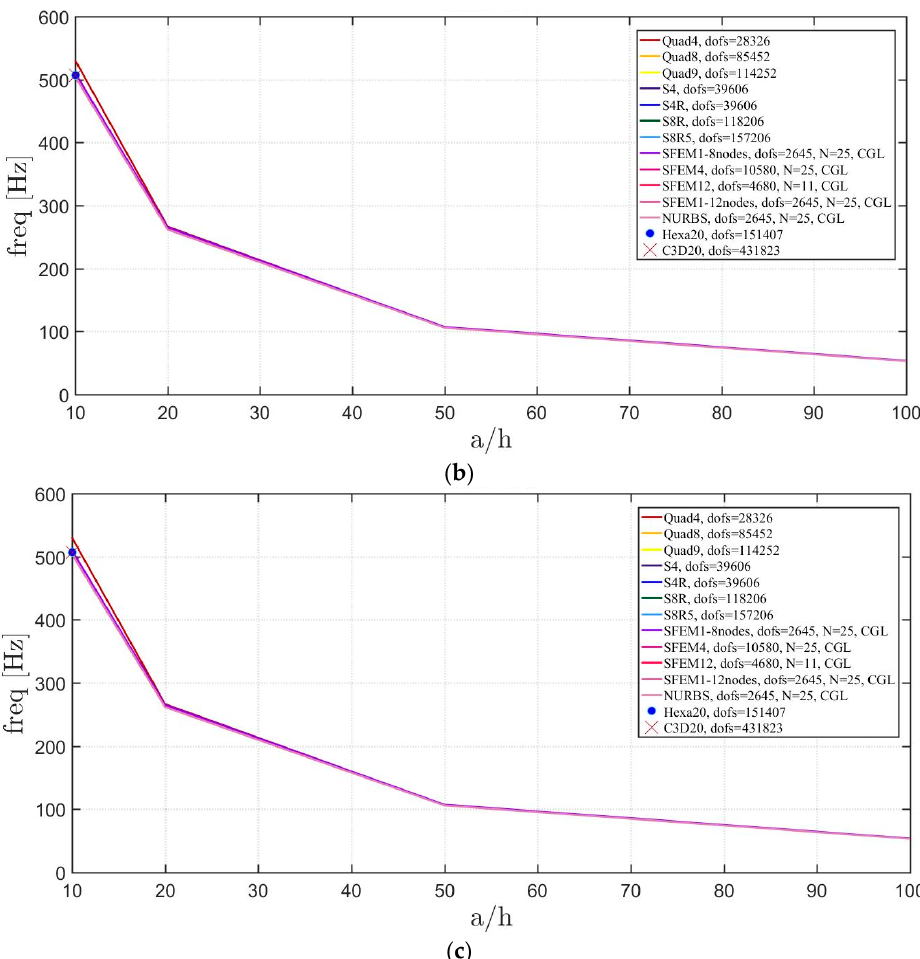
Figure 6. Thickness effect on the first three natural frequencies of an isotropic circular plate: ( a ) First frequency; ( b ) Second frequency; ( c ) Third frequency.